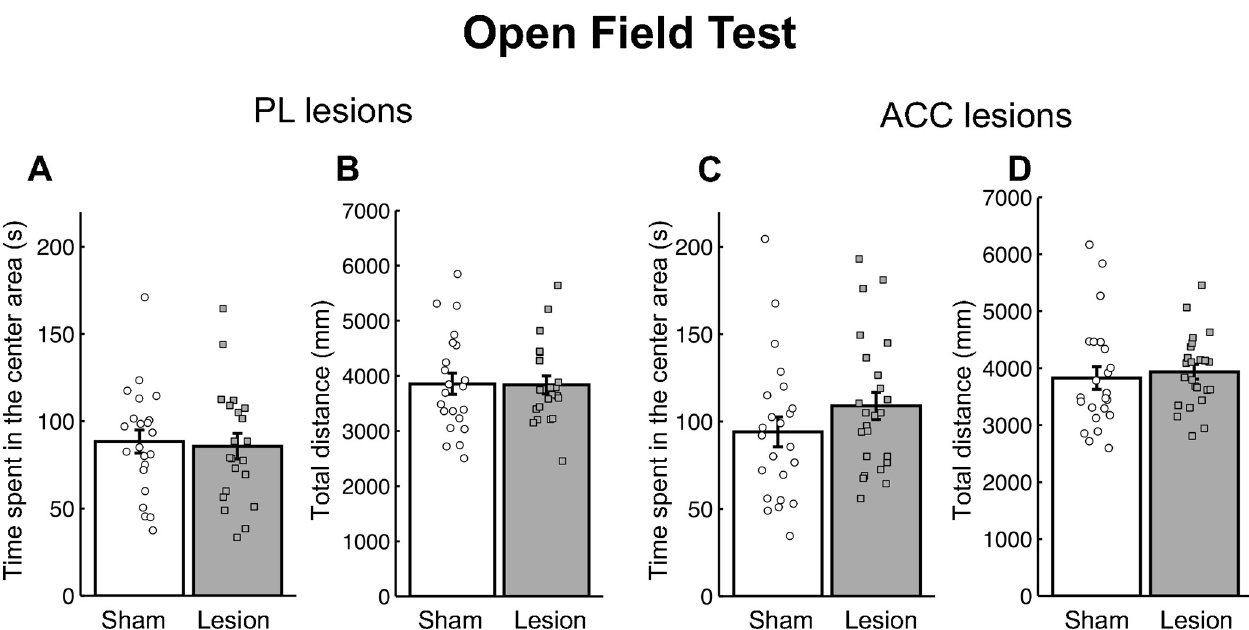
Fig 4. Results of the open field test in the prelimbic cortex (PL)- (A, B) and anterior cingulate cortex (ACC)- (C, D) lesioned mice. Time spent in the center area (A, C) and total distance traveled (B, D). The error bars indicate standard error. [PL sham group ( n = 22), PL lesion group ( n = 21), ACC sham group ( n = 23), ACC lesion group ( n = 24)].